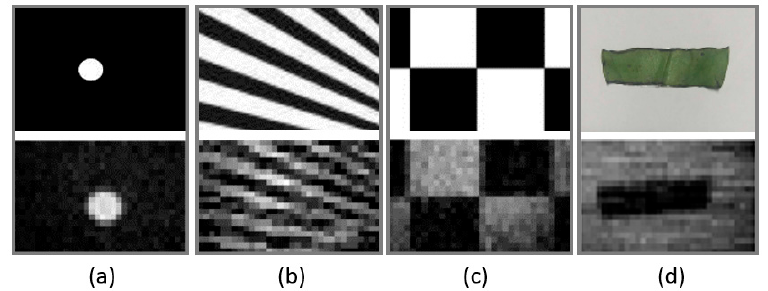
Figure 12. Different target objects and their image results. The objects in ( a – d ) correspond to the white circle, oblique stripe, checkerboard, and cut leaf, respectively.